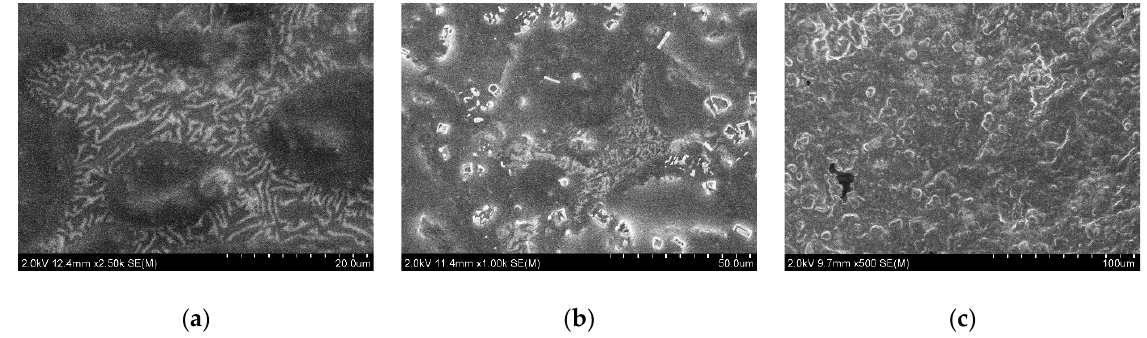
Figure 12. Iron powder (bright areas) distribution throughout the capsule: ( a ) Alg 70:Fe30; ( b ) Alg 50:Fe50; ( c ) Alg 20:Fe 80.